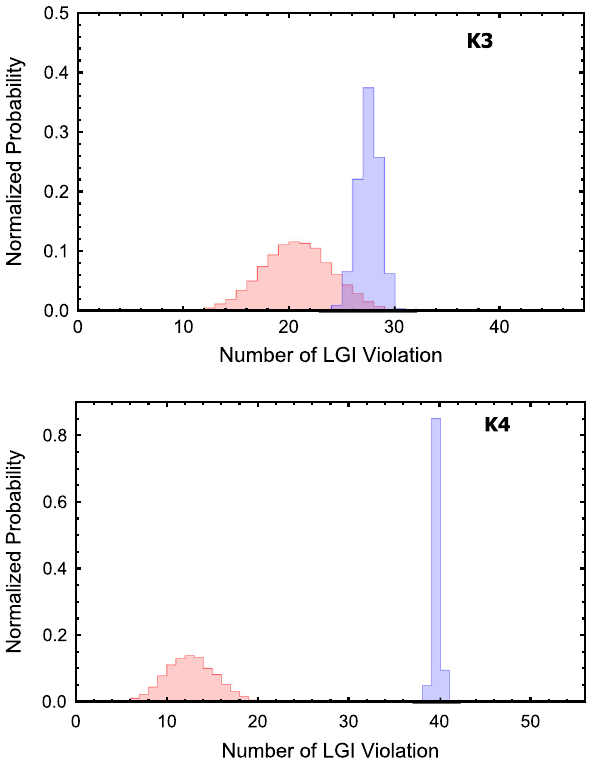
Fig. 3 The histograms of the number of K3 (upper) and K4 (lower) values that violate the LGI bound. The left curves with red filling indi- catetheexpectedclassicaldistributions,whiletherightcurveswithblue filling indicate the corresponding quantum quantity